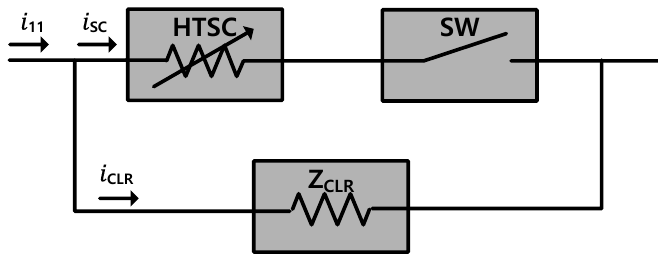
Figure 6. Configuration of the trigger-type